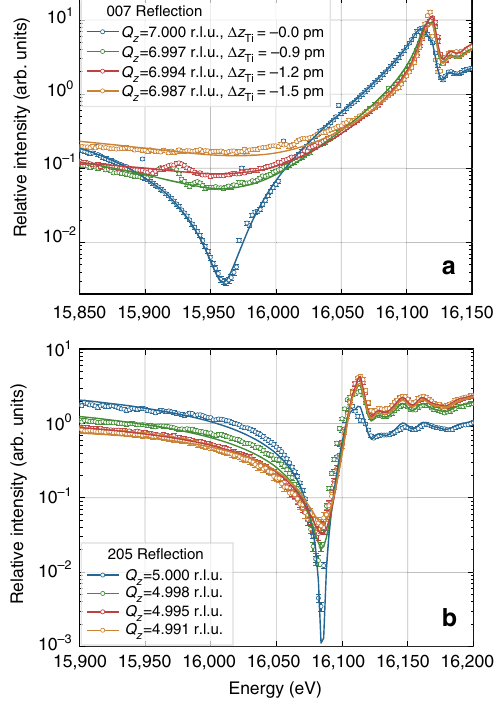
Fig. 7 Response of RXD curves to strain induced displacement in the MFP phase. Energy dependencies of the 007 ( a ) and 205 ( b ) re fl ections are shown for different positions on the diffraction pro fi le along Q z , including both MFP and cubic phase of SrTiO 3 , as indicated in the legend. Each selected value of Q z corresponds to a differently strained region in the sample given in terms of reciprocal lattice units (r.l.u.) with respect to the cubic state. The solid lines represent the best fi t after coupled variation of the z -positions of the atoms (see text) and error bars indicate the SD calculated from the incident and diffracted beam intensity. The corresponding results for titanium displacement are given in the